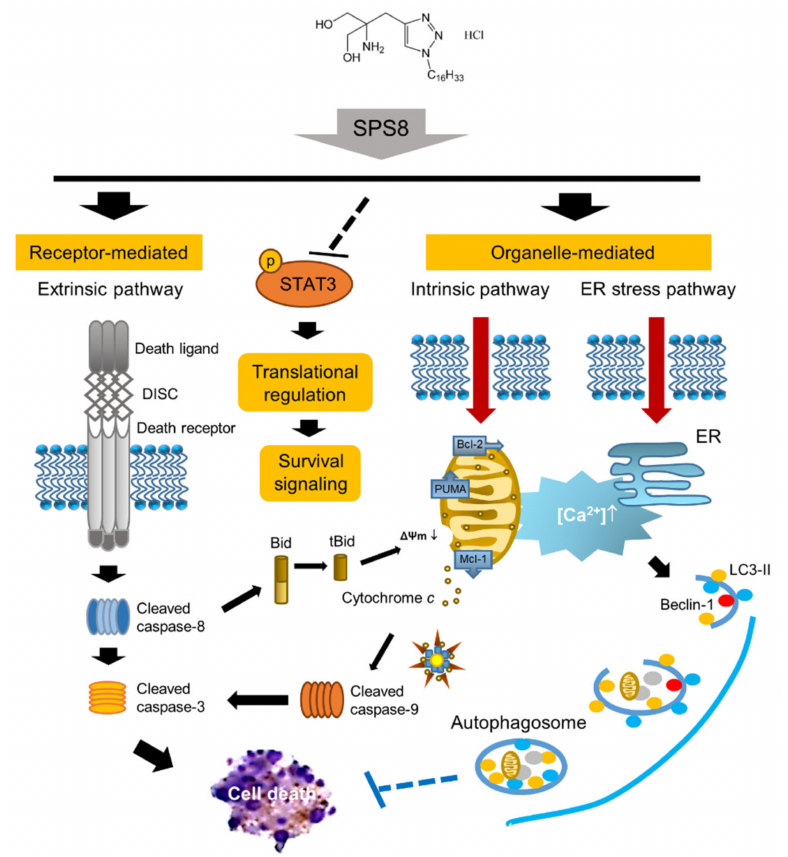
Figure 7. SPS8-mediated apoptotic signaling cascades in HL-60 cells. SPS8 induces the activation of both mitochondria-involved intrinsic and death receptor-mediated extrinsic apoptosis pathways, in which tBid serves as a crosstalk regulator, assisting the mitochondrial dysfunction caused by Mcl-1 downregulation / PUMA upregulation. Increased intracellular Ca 2 + mobilization contributes to both apoptosis and autophagy. However, autophagy may play a cytoprotective role in hindering SPS8 from cell apoptosis after a longer treatment time. Moreover, SPS8 can also suppress the phosphorylation of STAT3, thereby inhibiting the activation of cellular survival